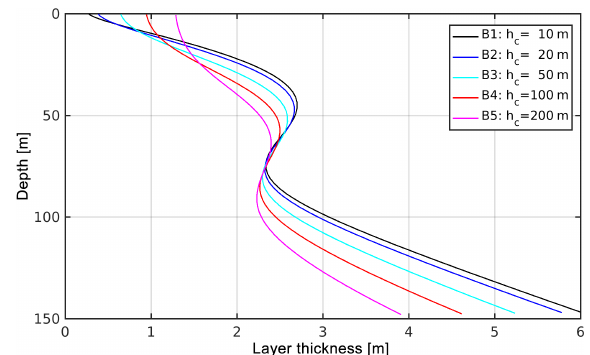
Figure 11. The layer thicknesses at the position of mooring M1 for various assumptions of the critical depth h c